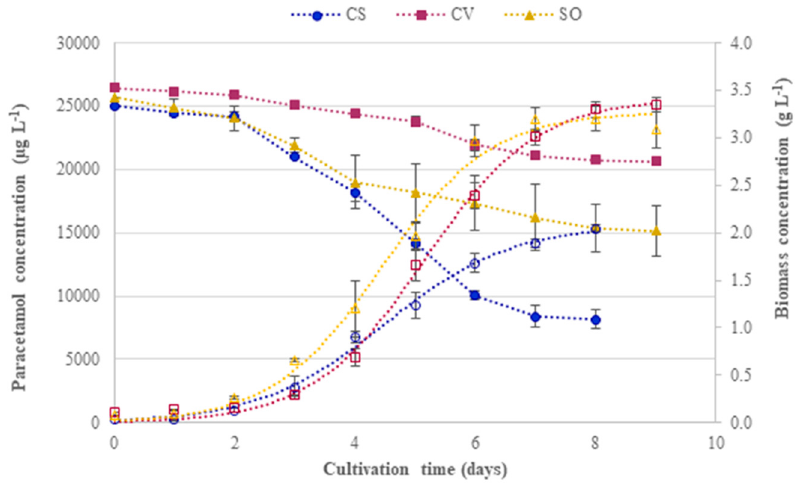
Figure 2. Concentration of acetaminophen (full symbols) and microalgae biomass (open symbols) in photobioreactors (PBRs) during the culture of Chlorella sorokiniana (CS) , Chlorella vulgaris (CV) and Scenedesmus obliquus (SO). Note: Mean results ( n = 3) are shown together with the corresponding SE.